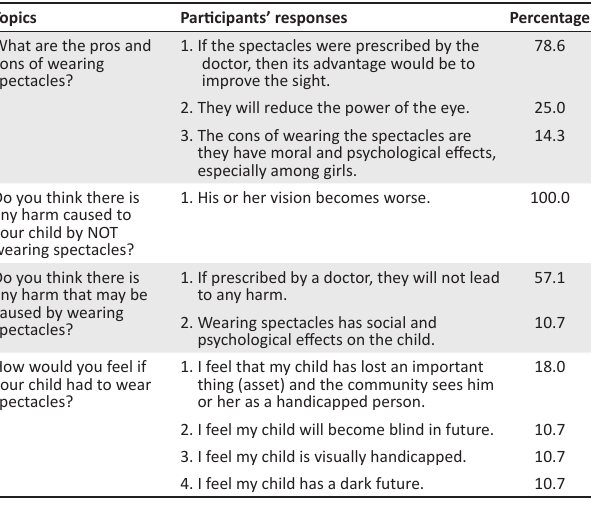
TABLE 3: Parents’ attitudes and perceptions towards spectacles wear and eye care.